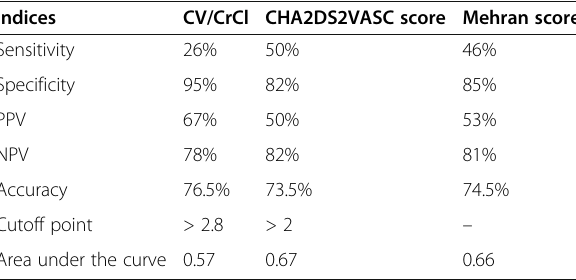
Table 4 Accuracy of different scores for the prediction of CIN among the studied patients